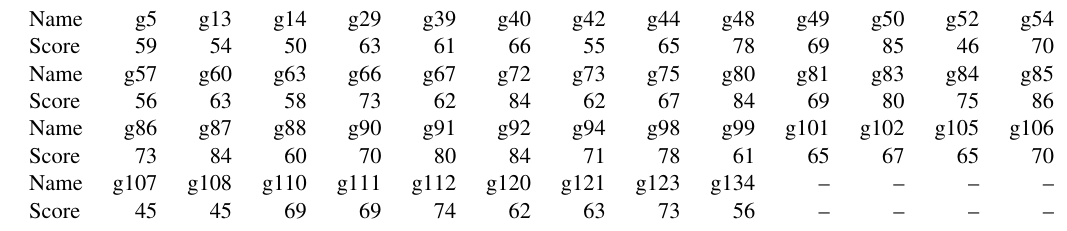
Figure 5. Graphical illustration of some Type A factors. A 1 is the planimetric (projected) area of the catchment, A 2 is the curved surface area of the catchment, A 4 is the perimeter of the catchment, A 6 is the curve length of the main channel, A 7 is the straight length of the main channel, and A 13 is basin volume. Table 2. Quantitative evaluation grade standard table for debris flow susceptibility.